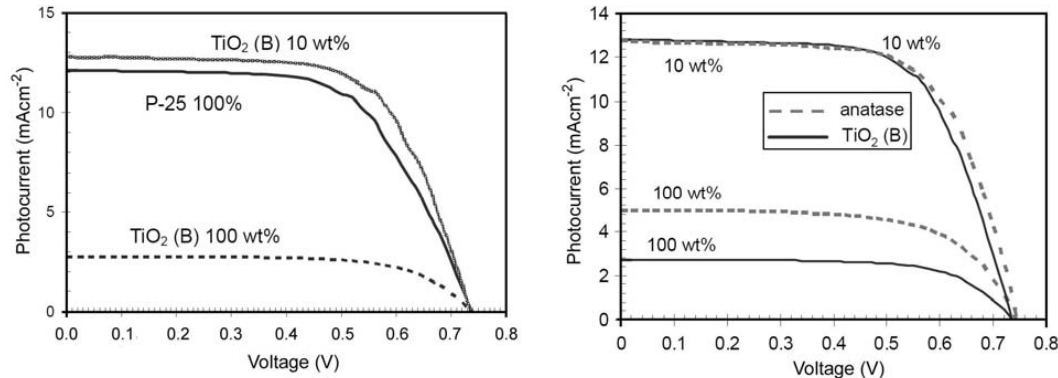
Fig. 9 Photocurrent-voltage characteristics of DSC: (left) made from 0 wt% nanowire (P-25 100 %), 10 wt%-TiO 2 (B) nanowire, and 100 wt%-TiO 2 (B) nanowire; (right) comparison between TiO 2 (B) and TiO 2